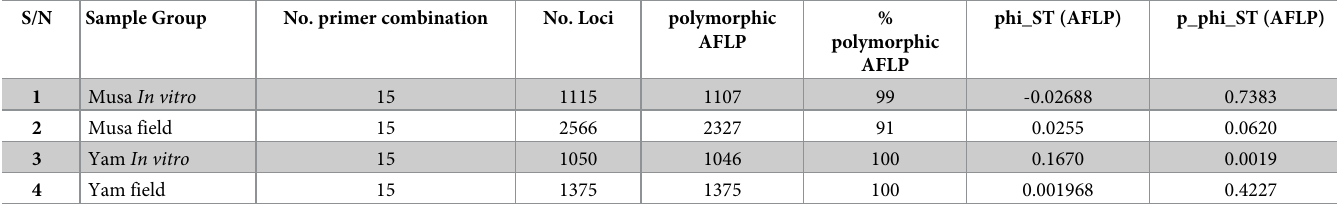
Table 3. AFLP profile summary for Musa and Yam under in vitro and field conditions. S/N Sample